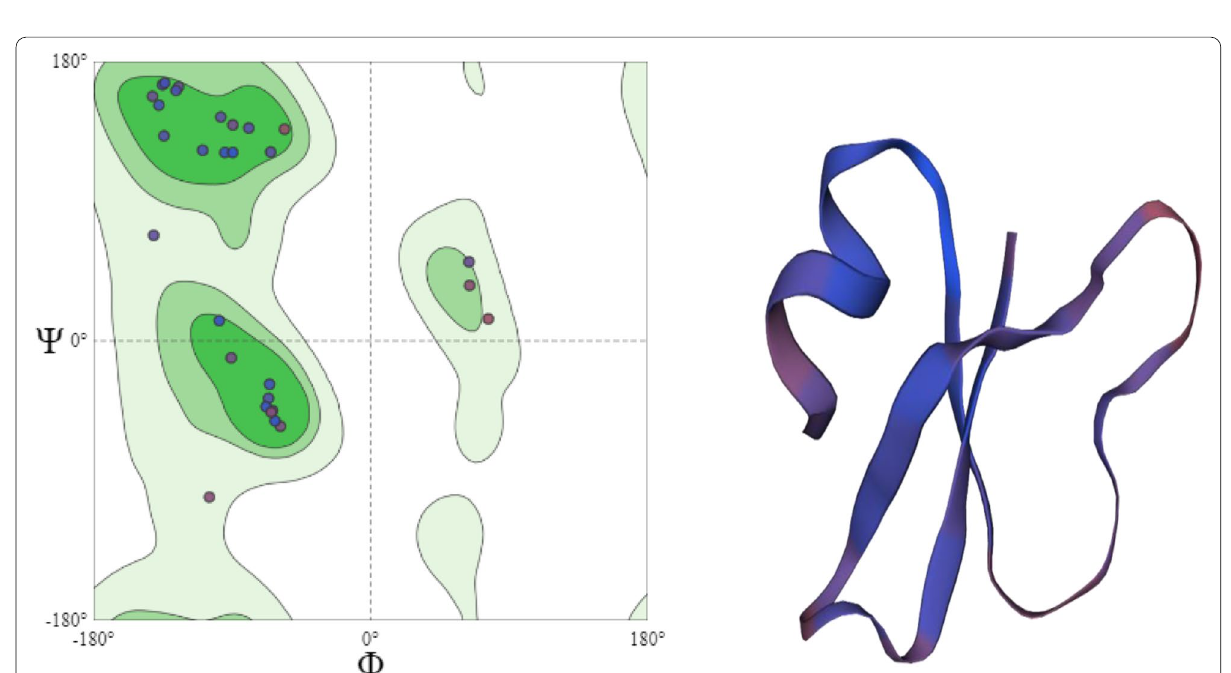
Fig. 4 Ramachandran plot and 3D structure of β-defensin